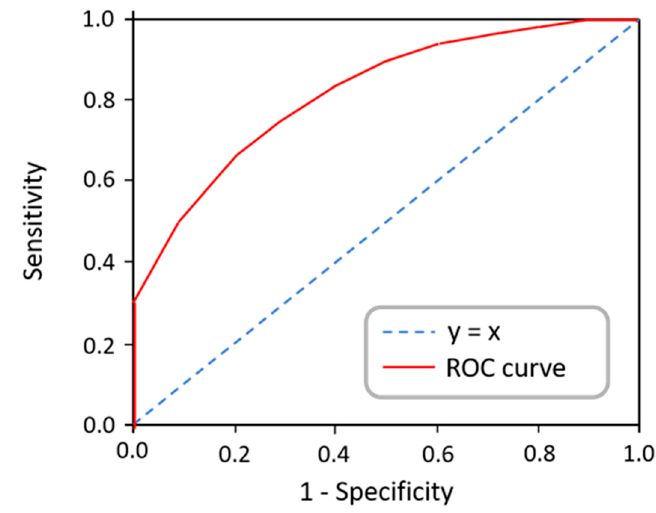
Figure 9. The ROC curve by setting the right ear stimulus as the target and the left ear stimulus as the non-target.